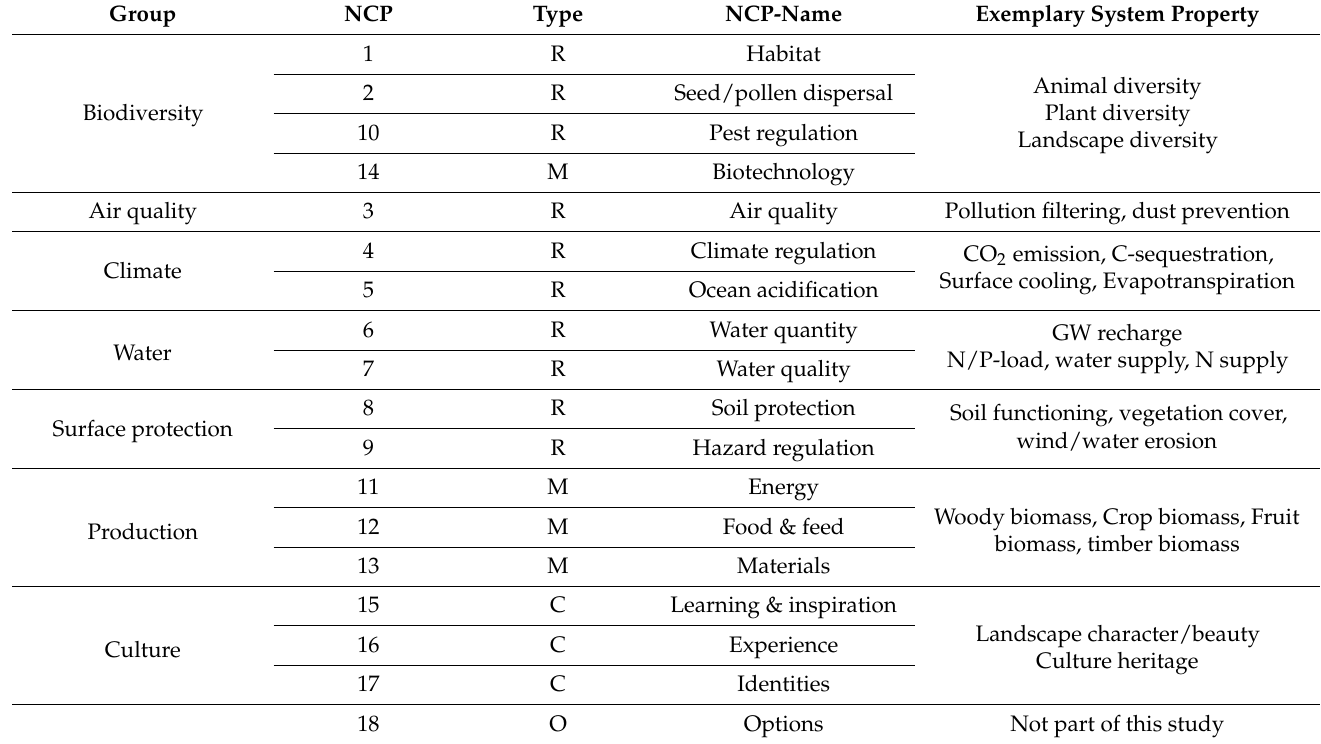
Table 1. Groups of nature’s contributions to people, summarized from Table A1 in D í az et al. (2018). The types are regulating (R), material (M), cultural (C), and options